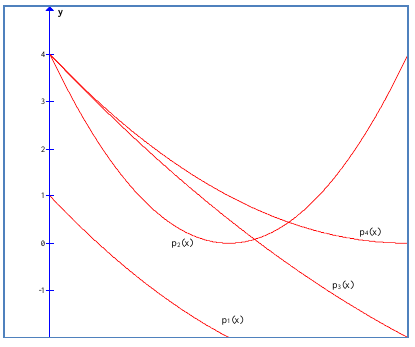
Figure A2. Several domination relationships.